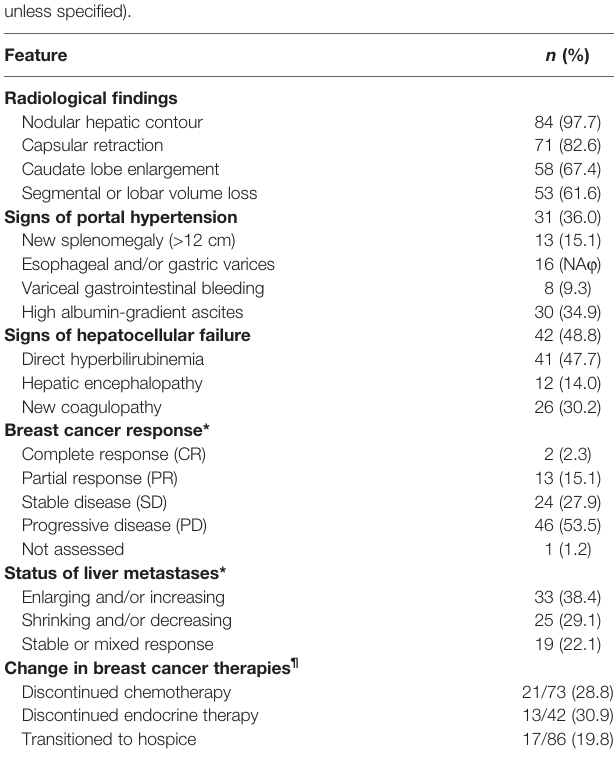
TABLE 1 | Baseline characteristics of breast cancer (n = 86).